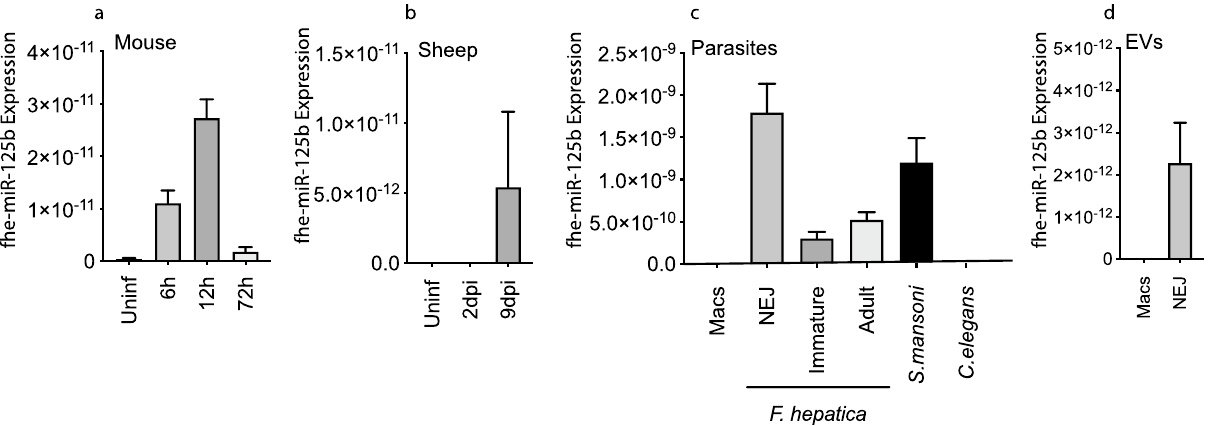
Figure 1. Worm-derived miRNA fhe-miR125b is detected within the peritoneal macrophages of mice and sheep infected with Fasciola hepatica . The presence of worm fhe-miR125b was ( a ) validated in the peritoneal macrophages that had been harvested from mice at 0 h, 6 h, 12 h and 72 h after an oral infection with 20 F. hepatica metacercariae and subjected to small RNA sequence analysis; and examined in ( b ) peritoneal cells harvested from uninfected sheep and from sheep at 2 and 9 days after an oral infection with 150 metacercariae. ( c ) The expression of fhe-miR125b was measured in RNA extracted from the F. hepatica newly excysted juveniles (NEJ), 21-day old worms (immature) and adult worms and compared to expression levels in adult (male and female mixed population) Schistosoma mansoni and Caenorhabditis elegans. ( d ) RT-qPCR using primers specific for fhe-miR125b was carried out on RNA extracted from NEJ extracellular vesicles (EVs). In these experiments, levels of fhe-miR125b expression determined by RT-qPCR are represented as the starting quantity of genetic material prior to amplification (N0) as determined by LinRegPCR (v.11). The data is presented as the mean ± SD of triplicate biological